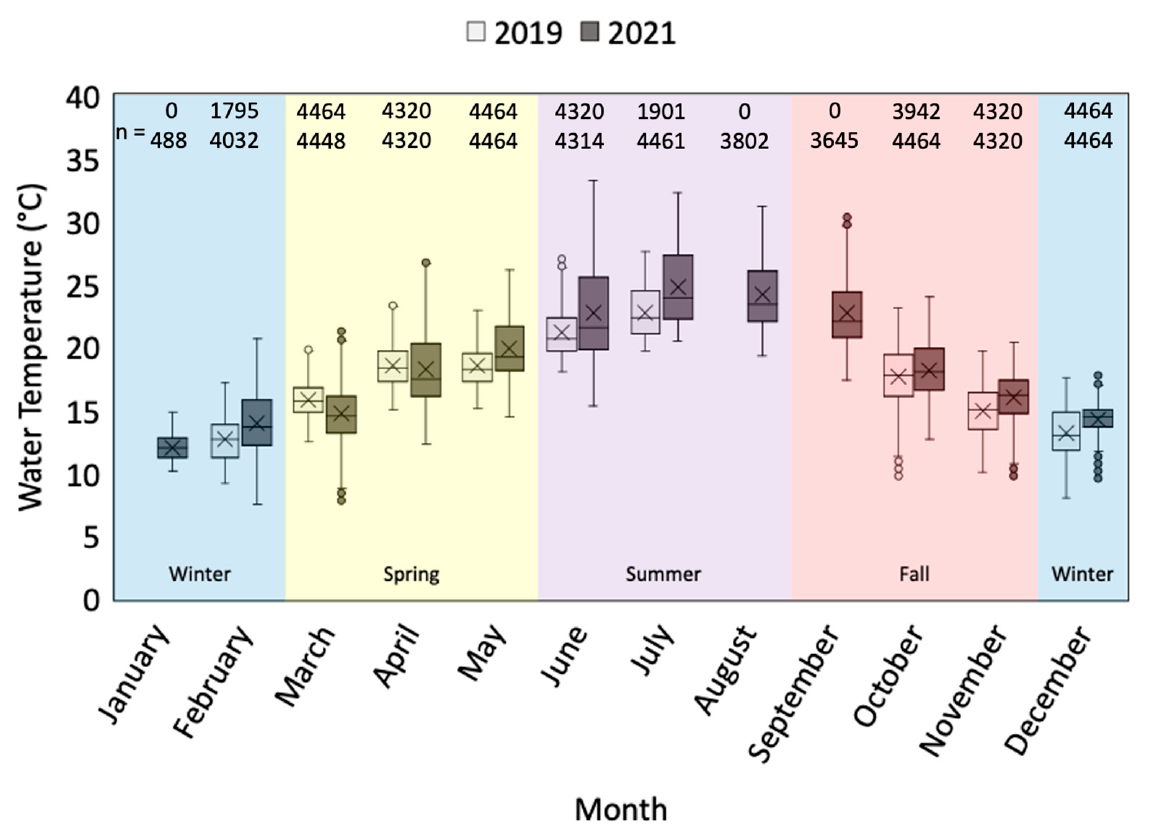
Figure 2. Boxplots of average monthly water temperatures for 2019 (light gray) and 2021 (dark gray). Seasons are shaded blue for winter, yellow for spring, purple for summer, and red for fall. The number of values, n, available in 2019 (top) and 2021 (bottom) are noted.